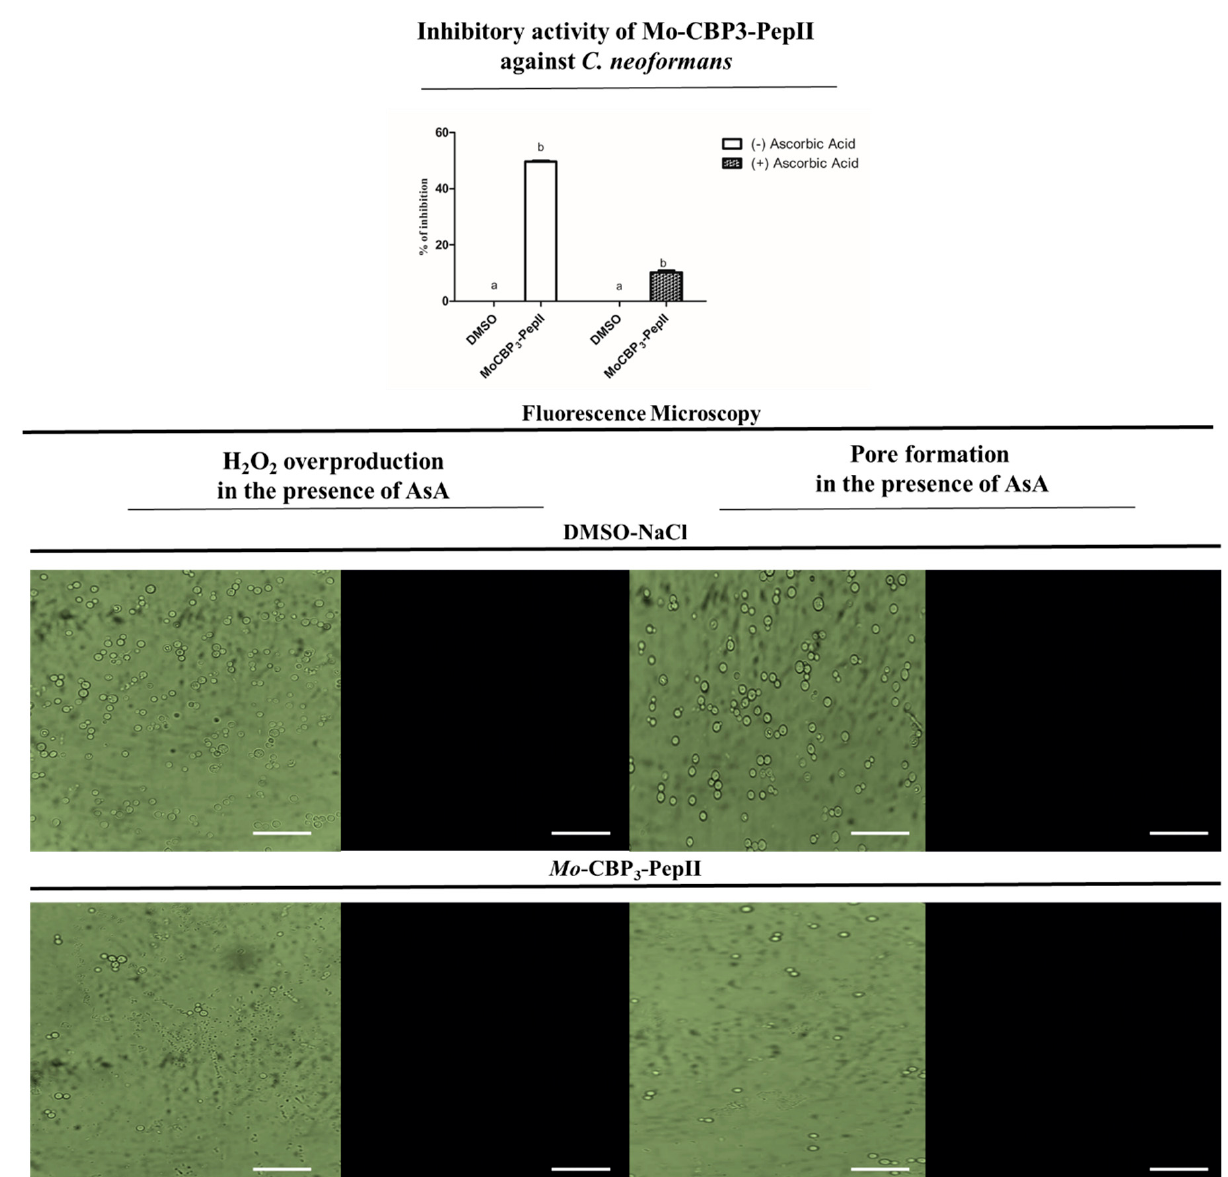
Figure 3. Effect of the antioxidant agent, ascorbic acid, in the activity of Mo-CBP 3 -PepII against C. neoformans . Graphic: Inhibitory activity of Mo-CBP 3 -PepII at MIC 50 concentration (25 µ g mL − 1 ) against C. neoformans in the presence and absence of 10 mM of ascorbic acid. Fluorescence Microscopy analysis showed no detection of H 2 O 2 and no pore formation in the cells of C. neoformans in the presence of 10 mM of ascorbic acid. Bars indicate 100 µ m. The different lowercase letters in (graphic) indicate statistical significance at p >